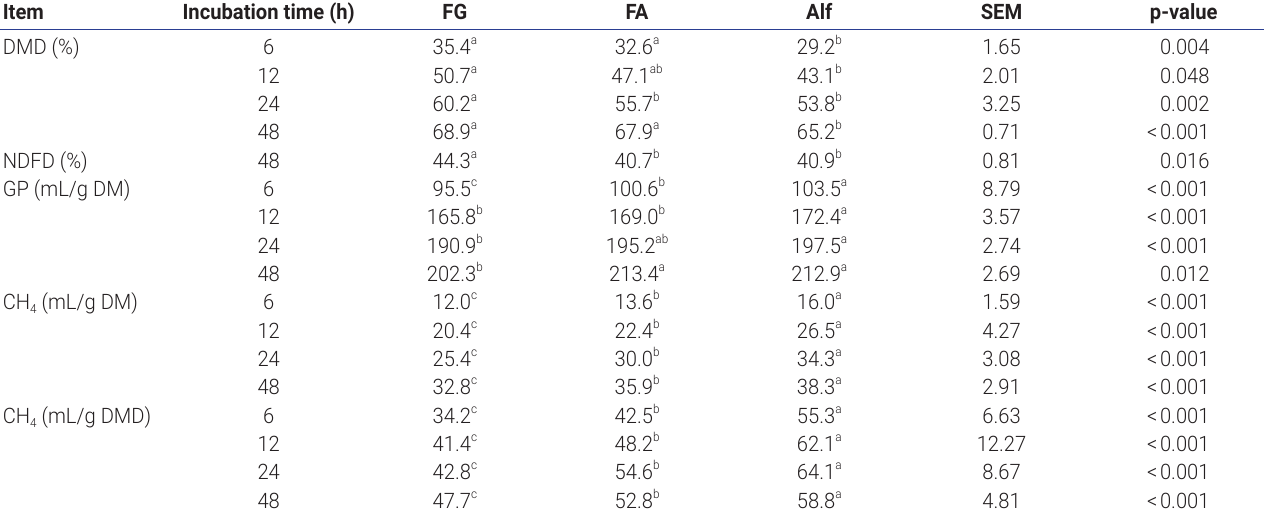
Table 3. Dry matter disappearance (DMD), neutral detergent fibre disappearance (NDFD), gas production (GP) and methane production during 48-h in vitro ruminal incubation of forages in the early growth Item Incubation time (h) FG FA Alf